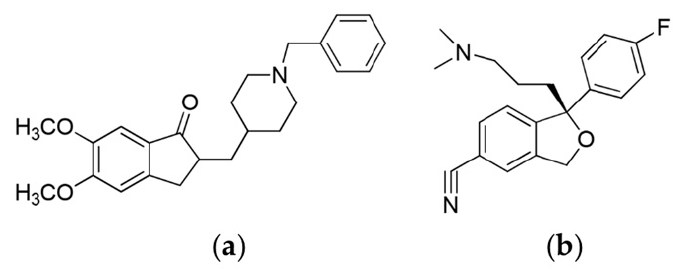
Figure 1. The chemical structures of ( a ) donepezil and ( b ) escitalopram (Internal Standard, IS). Donepezil is a small lipophilic molecule with a molecular weight of 379.2, making it well suited for transdermal delivery [21,25]. However, sustained release forms of trans- dermal patches for prolonged dosing intervals are still rarely available commercially.